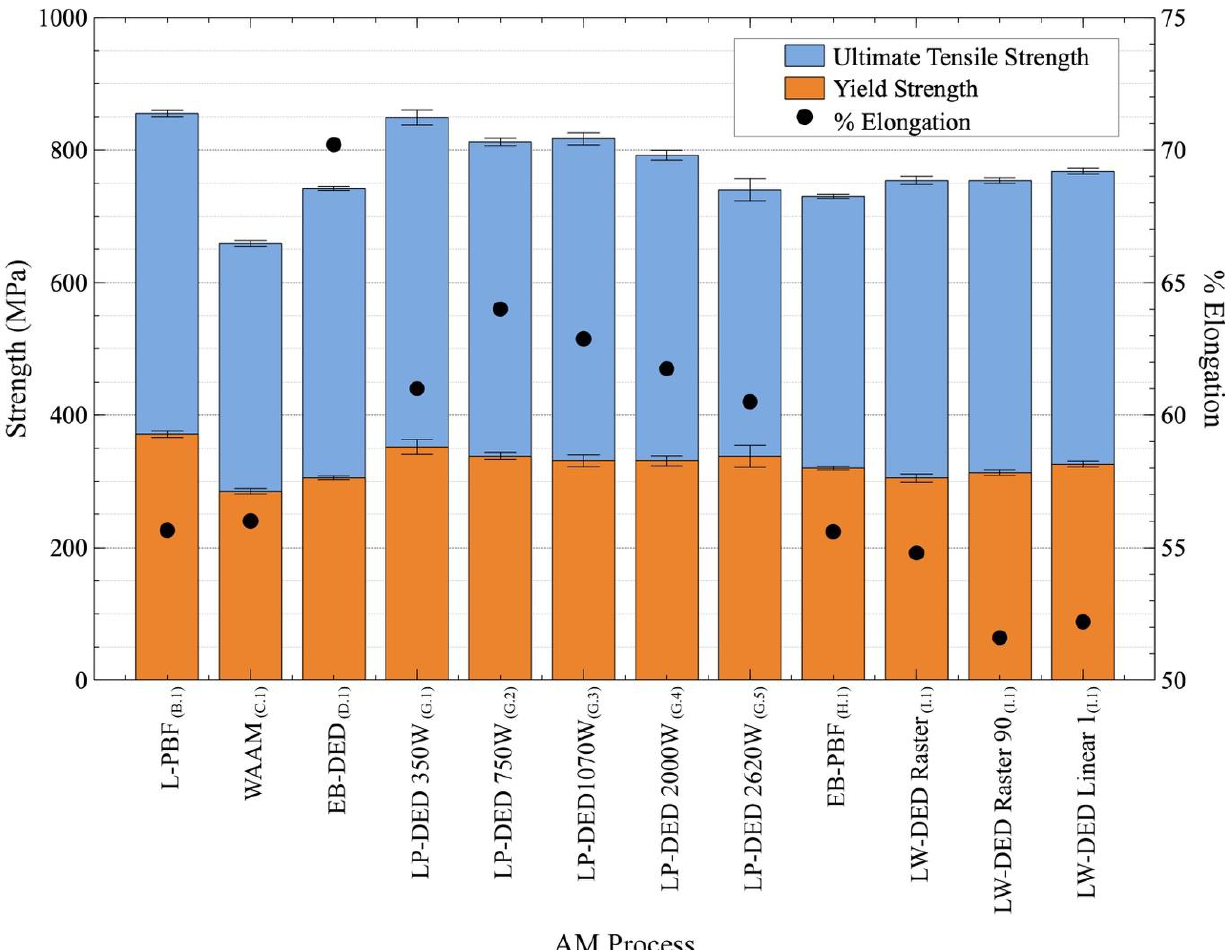
Figure 13. Summary of the ultimate tensile and yield strength of the specimens for heat-treated AM process samples.